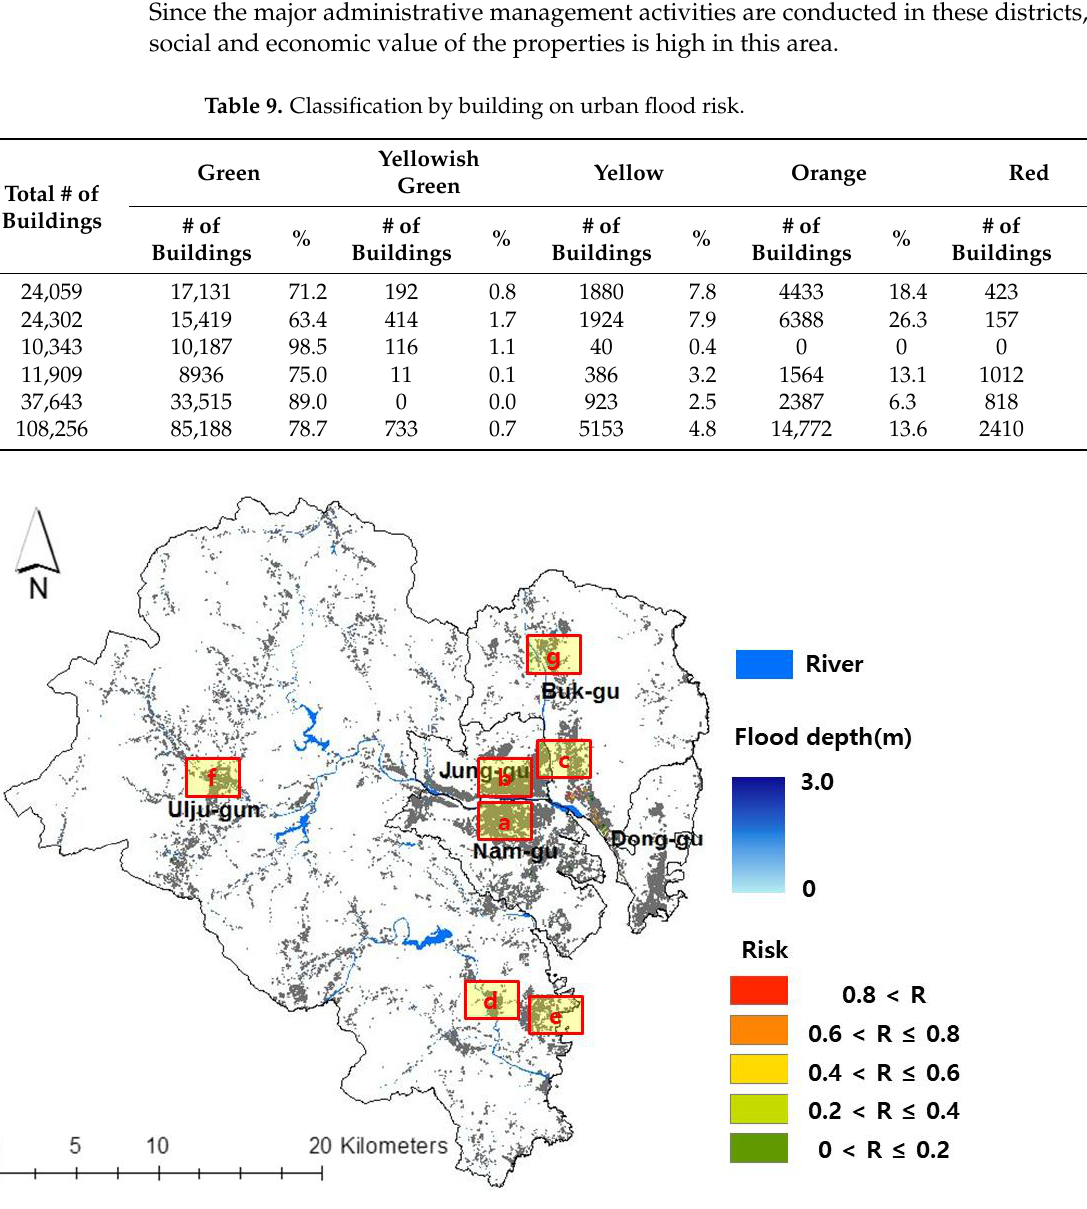
Figure 8. Classification by building on urban flood risk (key map).